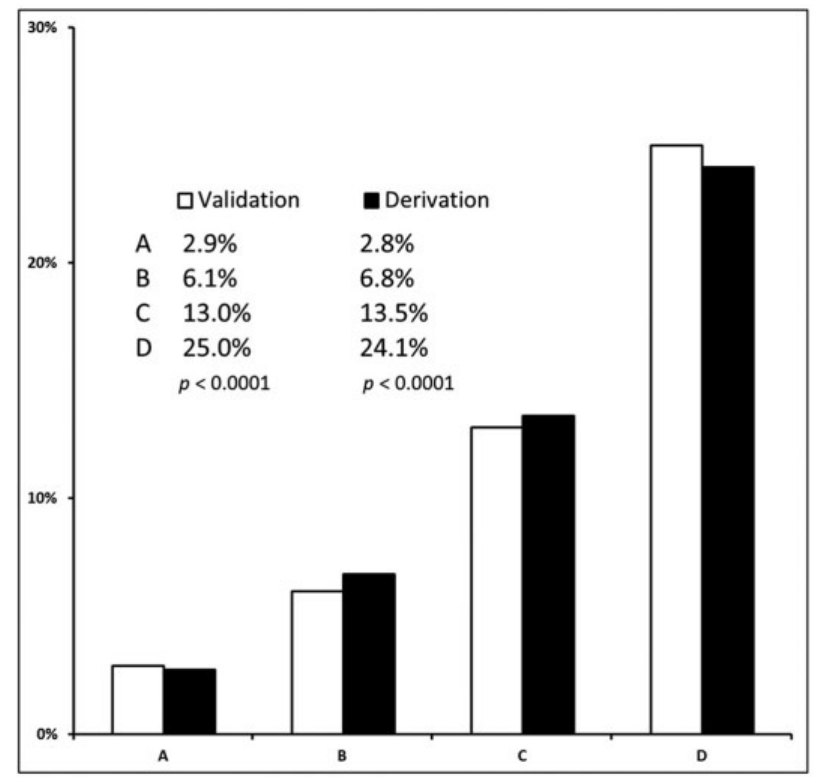
Fig. 3 Trends for early mortality after cancer-associated thrombosis in derivation and validation cohort. Cochran – Armitage p for trend in early mortality after CT for derivation and validation cohorts.